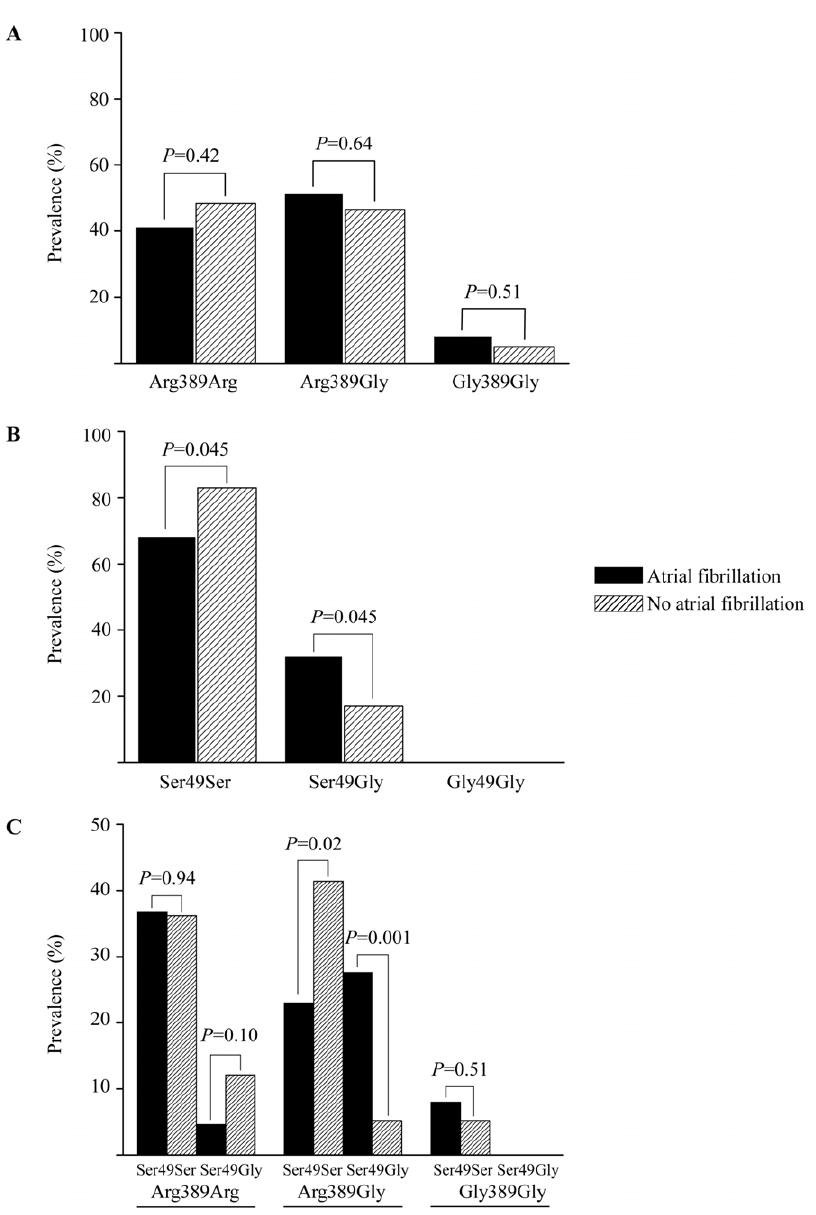
Figure 3. Relative allele distribution in patients with and without AF. A, P389 variants, B, P49 variants, C, combined genotype of P389 and P49 variants.